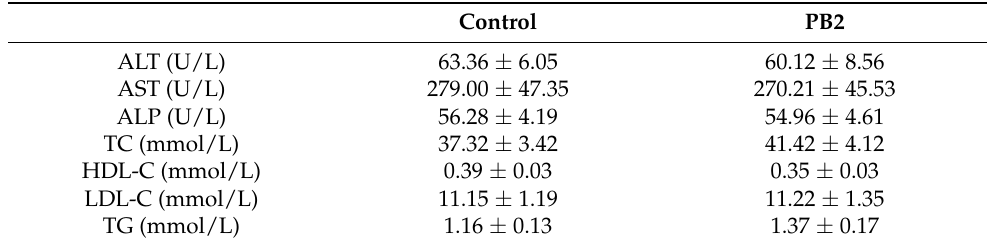
Table 1. Effect of PB2 on the activity of aminotransferase and ALP, as well as lipid profiles, in apoE − / − mice.